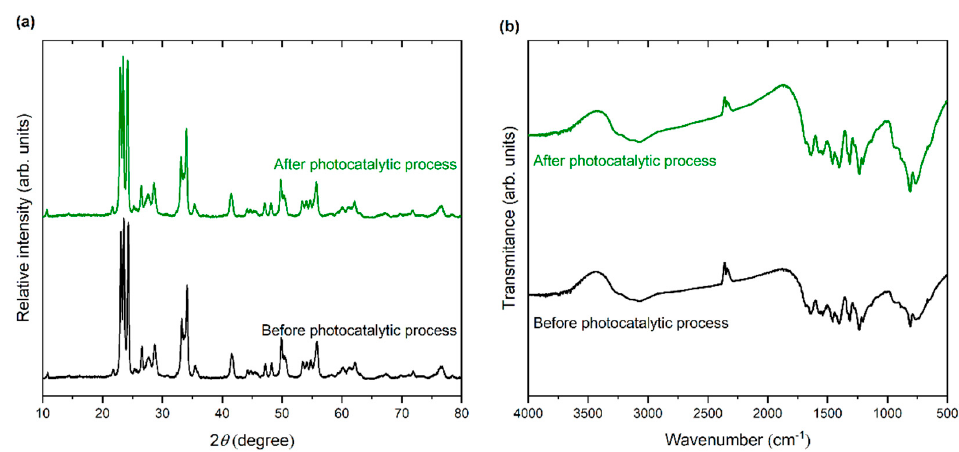
Figure 11. ( a ) XRD patterns and ( b ) FTIR spectra of WO 3 /S-doped g-C 3 N 4 before and after the photocatalytic process.